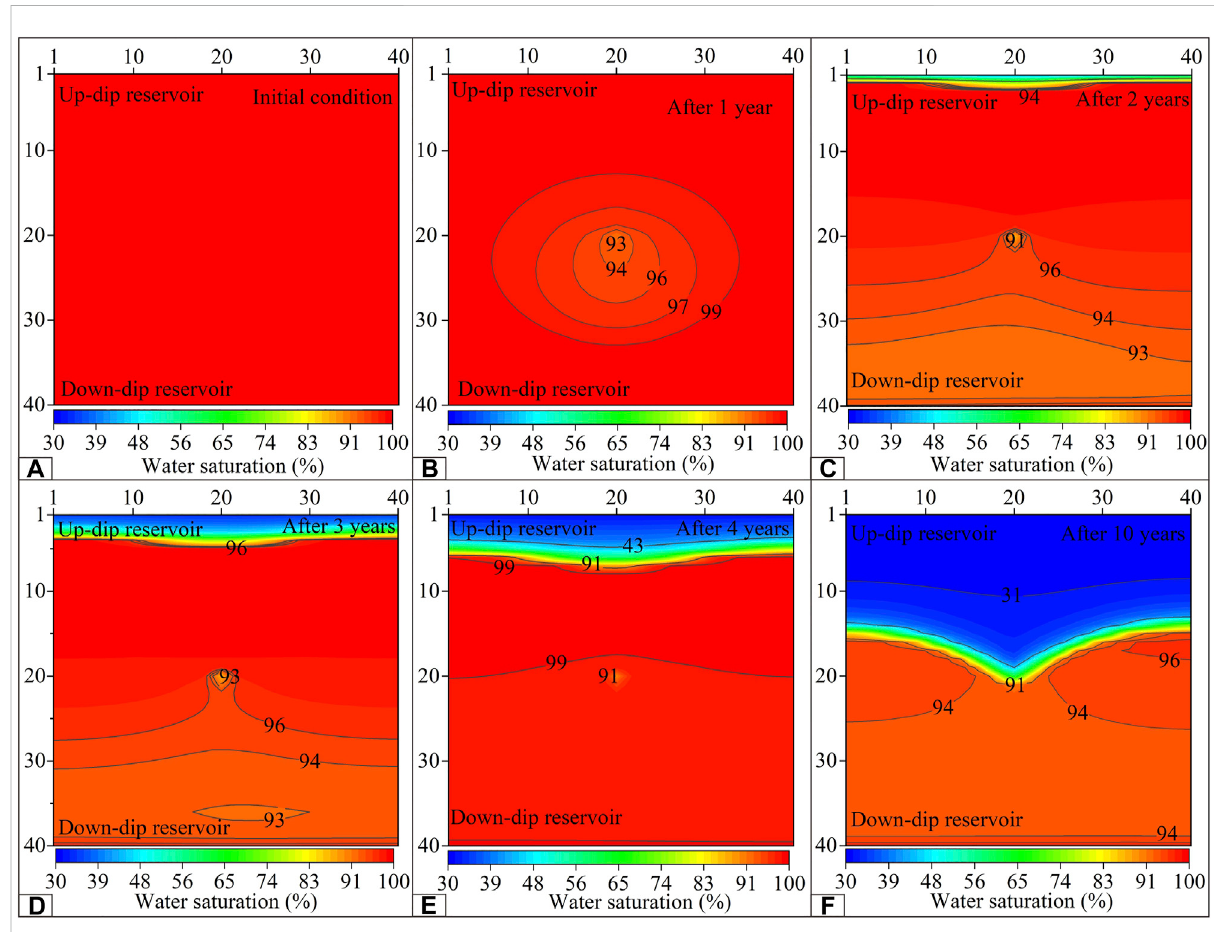
FIGURE 10 (A) Initial water saturation distribution of ISIM. (B) Water saturation distribution after 1 year of drainage in ISIM. (C) Water saturation distribution after 2 years of drainage in ISIM. (D) Water saturation distribution after 3 years of drainage in ISIM. (E) Water saturation distribution after 4 years of drainage in ISIM. (F) Water saturation distribution after 10 years of drainage in ISIM.